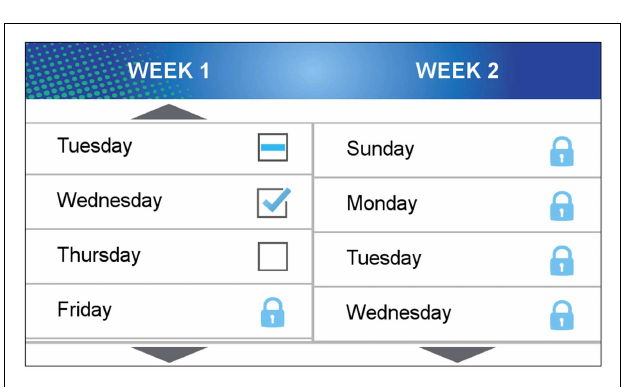
3 Pilot testing raised concerns that some participants may select various doing some- thing else options more often than the research team would like. Therefore, these